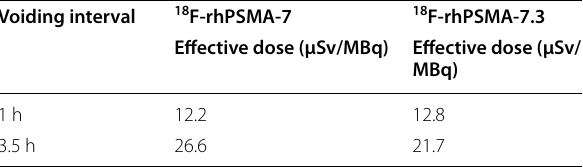
Table 2 Dosimetry results using 1 h and 3.5 h voiding interval Voiding